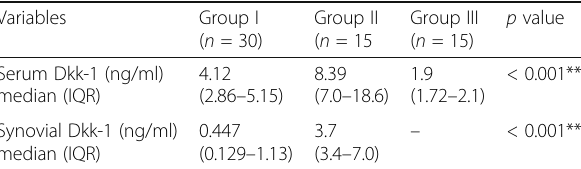
Table 2 Serum and synovial levels of Dkk-1 in the studied groups showing that group II has the highest serum level among the 3 studied groups and that it also has a higher synovial level than group I p value Variables Group I Group II Group III ( n = 30) ( n = 15 ( n = 15)